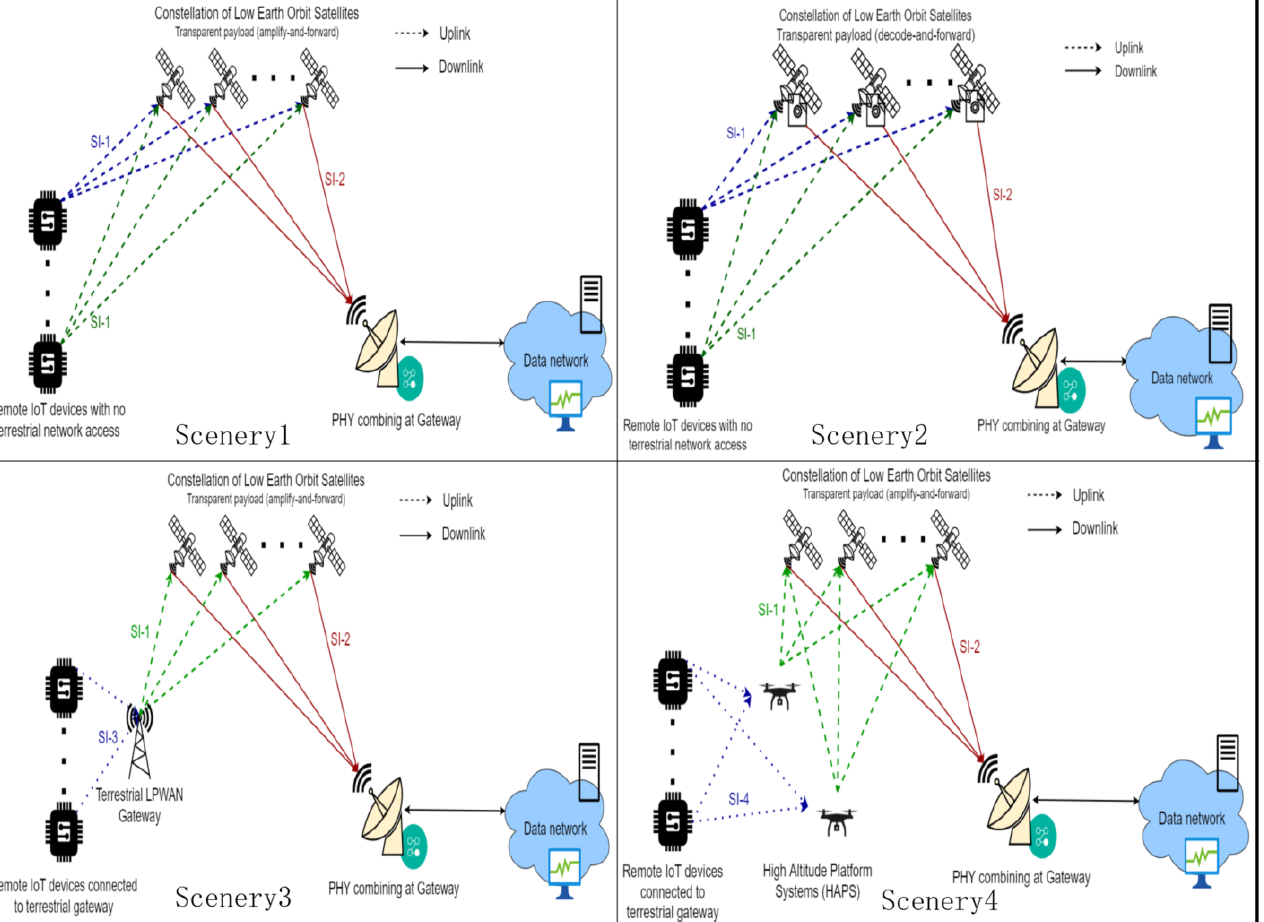
Figure 3. Four different sceneries of network design.